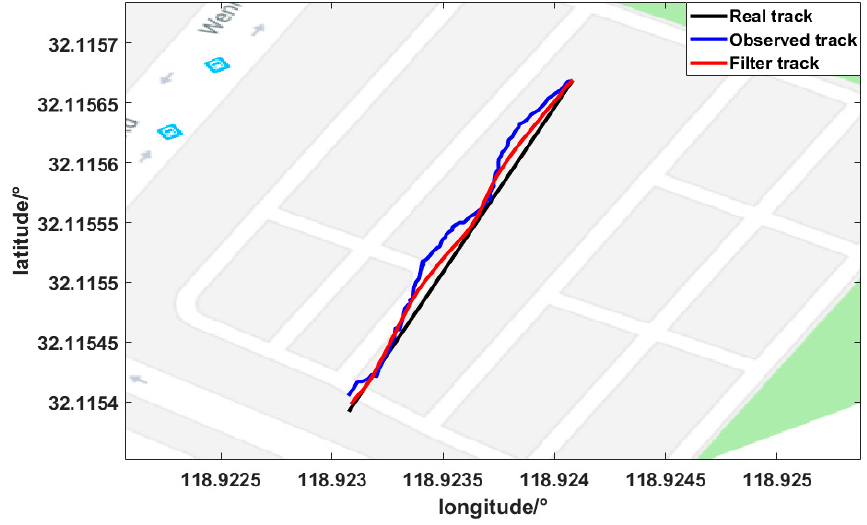
Sensors 2019 , 19 , x FOR PEER REVIEW